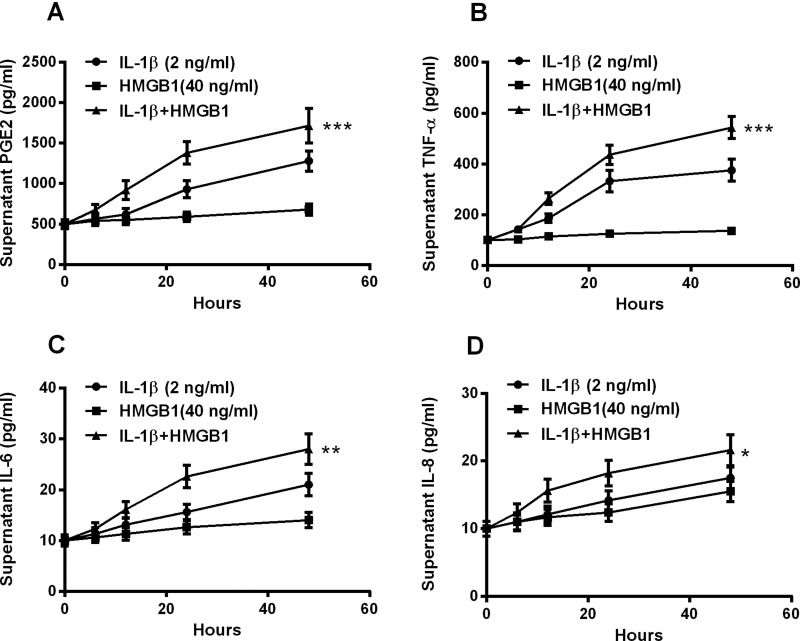
Additive inductions by IL-1β and HMGB1 of PGE2, TNF-α, IL-6 and IL-8 in disc annulus fibrosus cellsDisc annulus fibrosus cells were treated with 2 ng/ml IL-1β or (and) with 40 ng/ml HMGB1 for 0, 6, 12, 24 or 48 h, then the supernatant levels of PGE2 (A), TNF-α (B), IL-6 (C) and IL-8 (D) were examined with ELISA methods. Results are presented as mean ± S.E.M. for quartic independent experiments. P values were calculated by parametric ANOVA (Tukey–Kramer post hoc) test. *P<0.05, **P< 0.01, ***P<0.001 or ns: no significance.